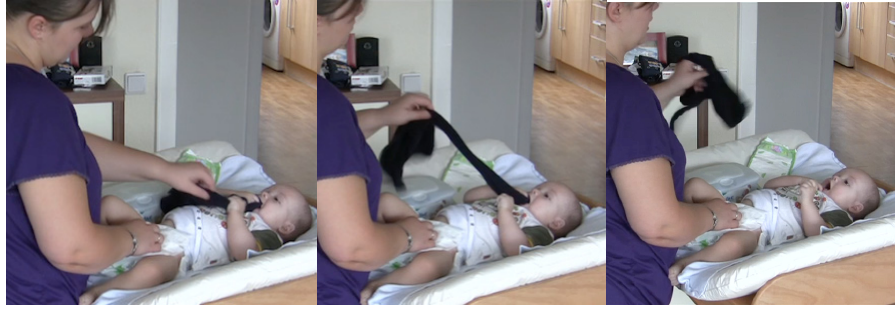
Figure 6. A mother commenting on the infants’ action.